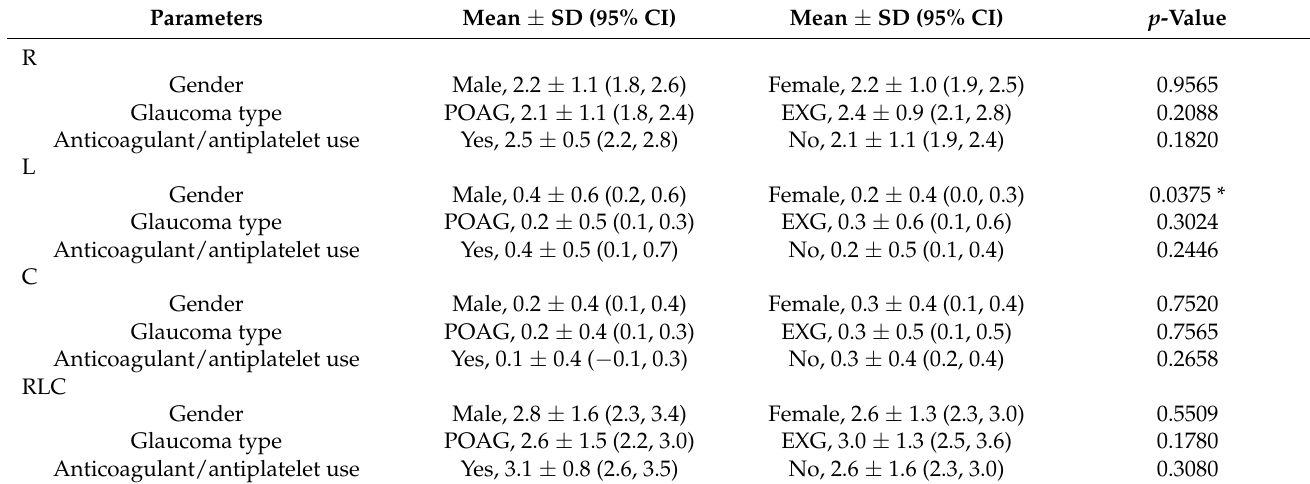
Table 5. Possible associations between RLC scores on postoperative day 1 and various categorical parameters.